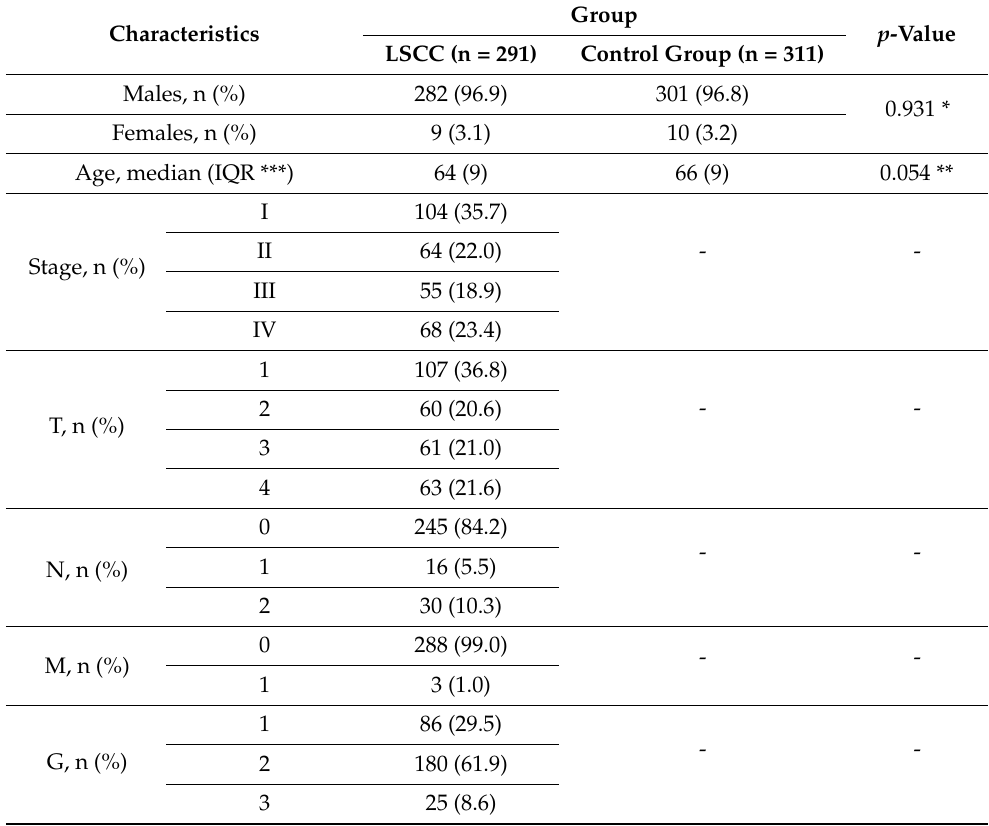
Table 1. Demographic characteristics of the study groups. Characteristics